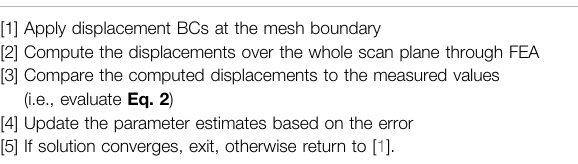
Algorithm 1 | Optimization-based QUSE Inverse